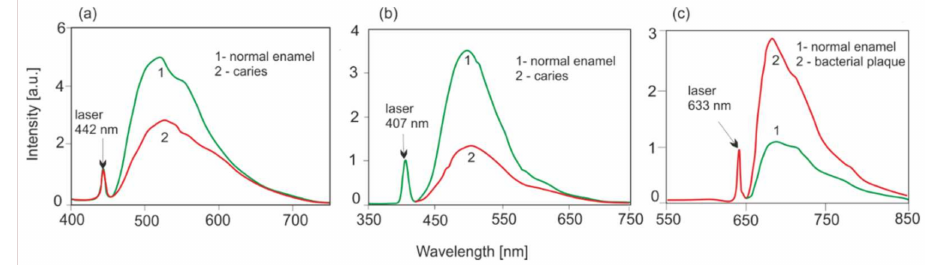
Figure 5. Influence of the excitation wavelength with laser radiation on changes in the level of enamel fluorescence: ( a ) laser 442 nm, ( b ) laser 407 nm, ( c ) spectra of bacterial plaque with excitation 633 nm.